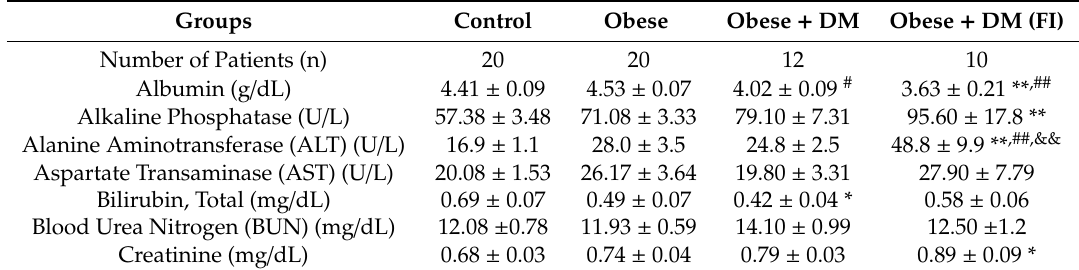
Table 2. Summary of complete chemical and liver profile in study subjects.